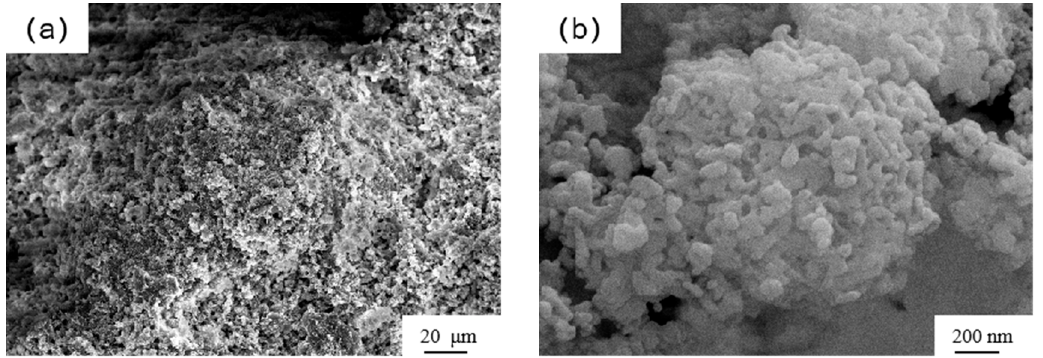
Figure 2. Scanning electron microscopy of belite cement clinker: ( a ) particles; ( b ) powders.